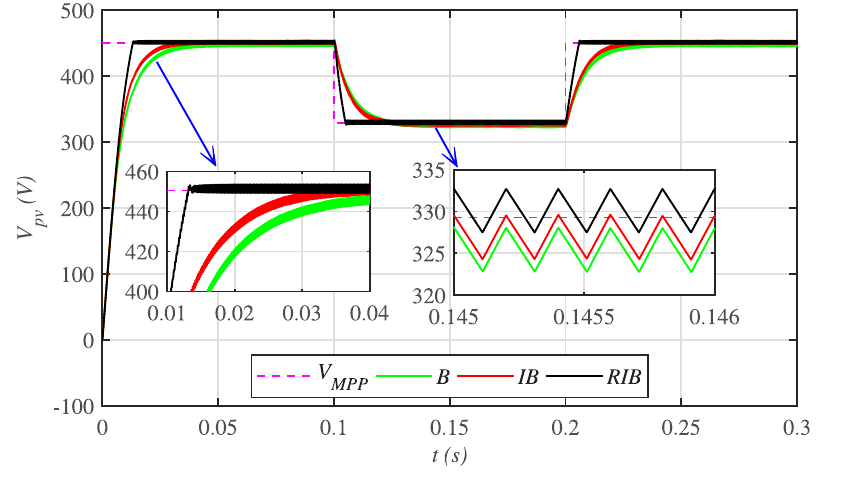
Fig 10. PV array comparative voltages under case